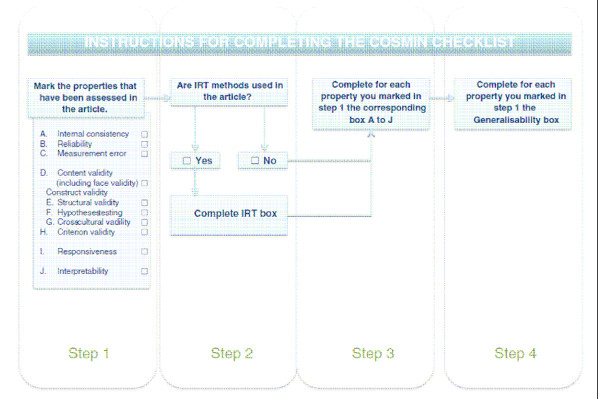
COSMIN checklist. The 4-step procedure to complete the COSMIN checklist for evaluating the quality of studies investigating the psychometric properties of health-related PRO questionnaires [15].